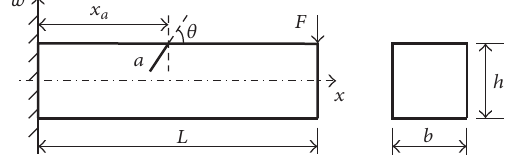
Figure 1: Geometric model of a cantilever beam with an oblique crack.